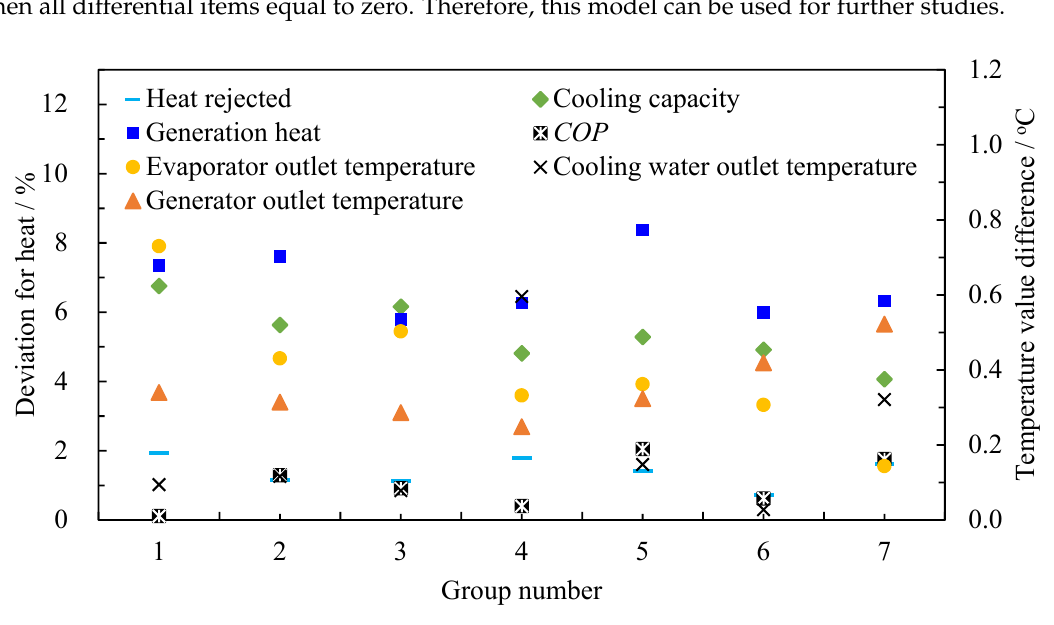
Figure 4. Comparison between the model and the experiment; COP : coefficient of performance.